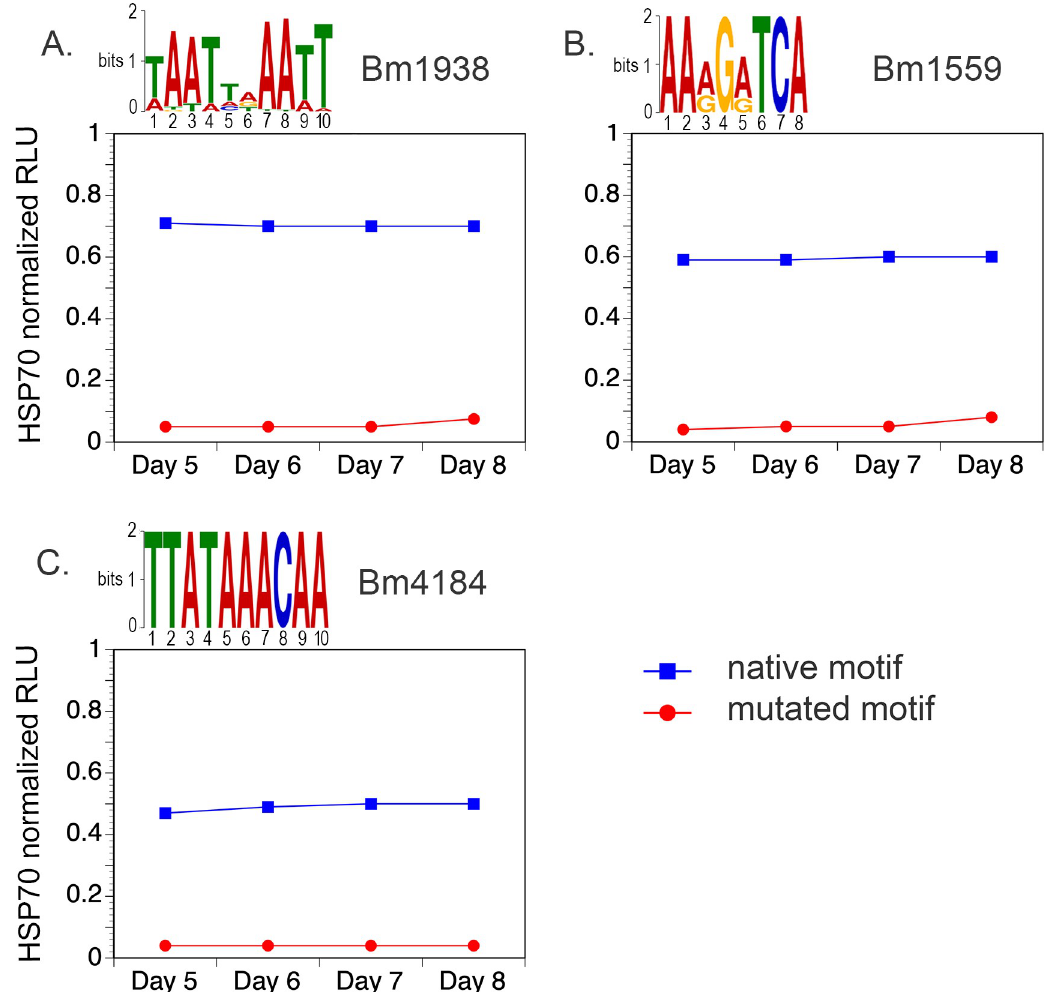
promoter of Bm1938 and a mutated motif M6 version of the promoter. C) Promoter motif validation using the native promoter of Bm4184 with a mutated motif M7 version of the promoter. A total of four wells, each containing 100 L3, were transfected